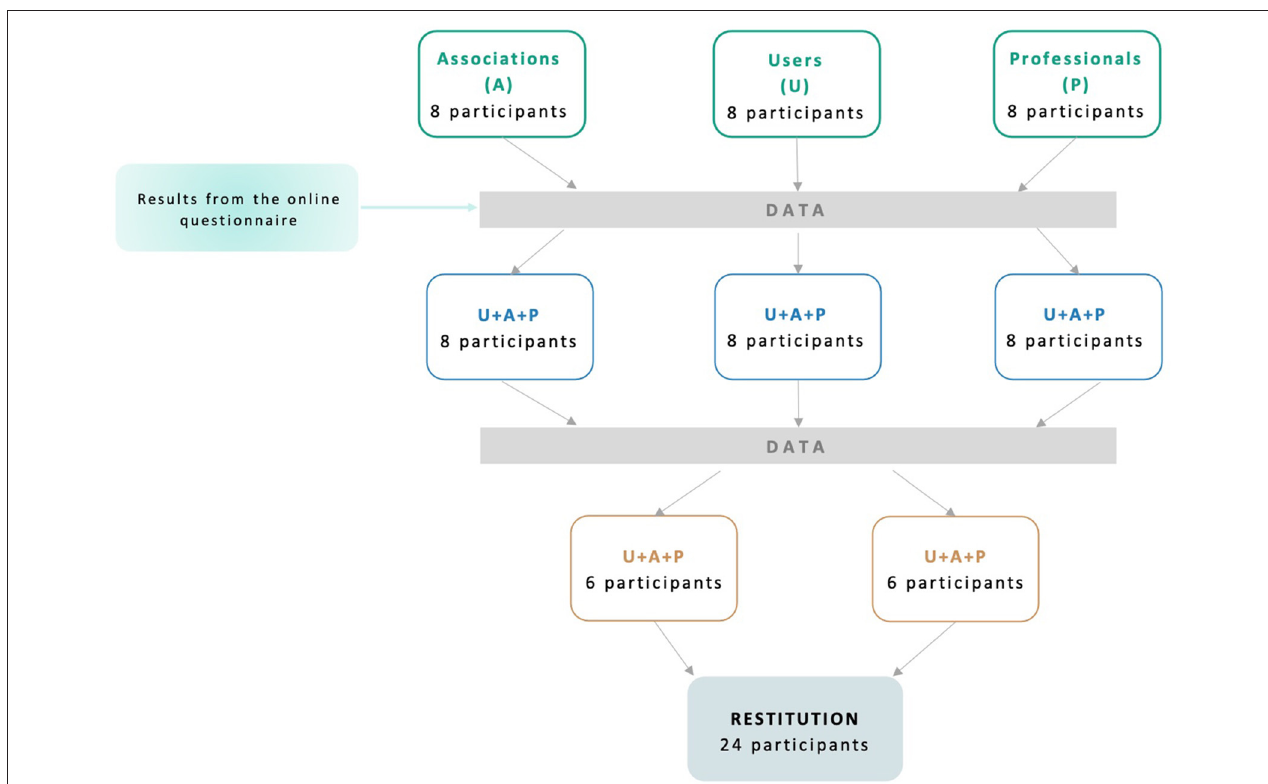
FIGURE 3 | Schematic overview of the relevance